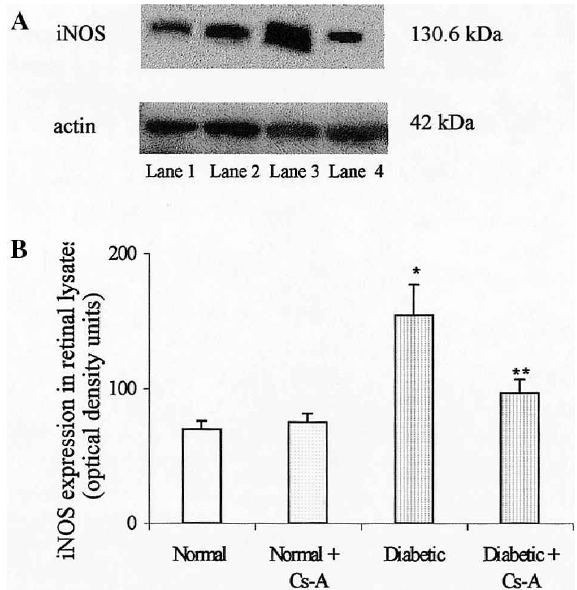
FIG. 3. Study of the expression of iNOS protein. (A) Western blot for detection of iNOS protein expression in retina. Retinal lysates were subjected to electrophoresis followed by immunoblotting with a polyclonal antibody against iNOS. Lane 1: retinal lysate from normal rats; Lane 2: retinal lysate from Cs-A treated normal rats; Lane 3: retinal lysate from diabetic rats; Lane 4: retinal lysate from diabetic rats. This figure is representative of 5 identical experiments. (B) Densitometric analysis of iNOS expression. Anti-actin was used to ensure that the protein loading was equivalent. Data are mean ± SD values from 5 rats from each group. *Significant differences from normal rats. **Significant differences from Cs-A non-treated diabetic rats ( p < 0.05) (one-way ANOVA analysis, Dunnett’s test).